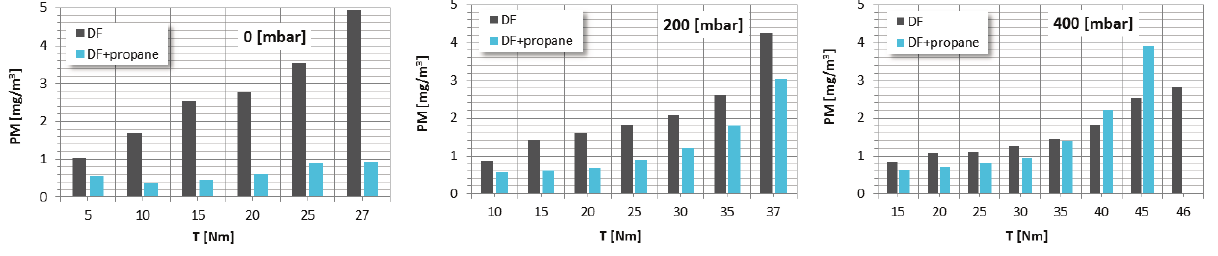
Fig. 5. Load characteristics of particulate matter (PM)concentration in the exhaust gas for both investigated engine operating modes